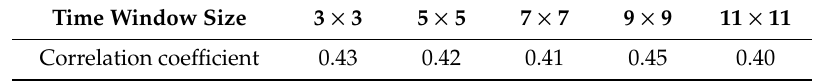
Table 6. Correlation coe ffi cient for di ff erent time windows after denoising based on median